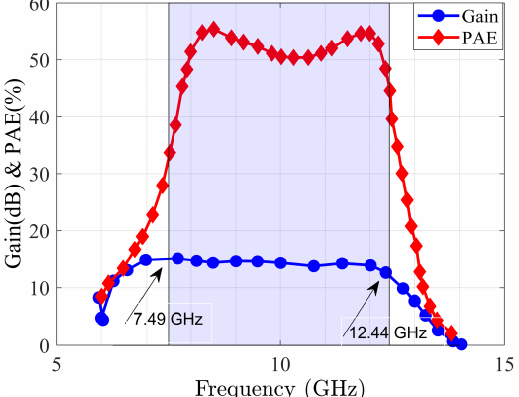
Figure 11. Gain and PAE of optimized MMIC design through DNN at 38 dB output power.